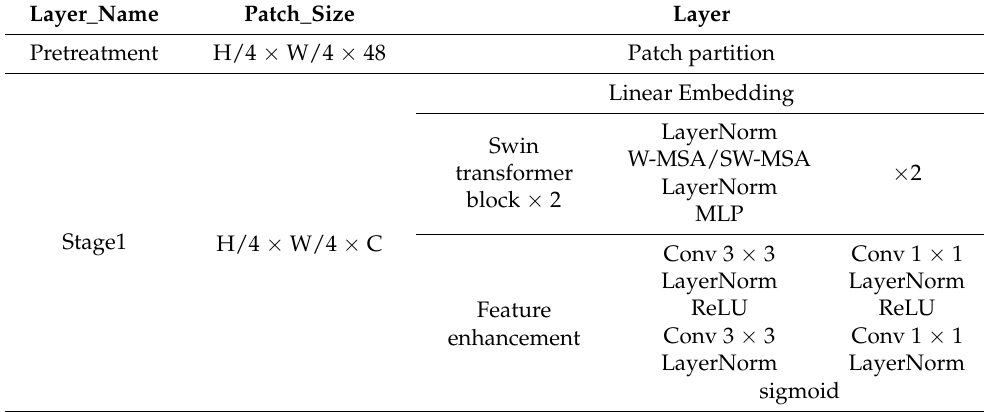
Figure 5. The architecture of ESTDNet. Using the FESwin and AFF modules is shown in detail. Table 1. The FESwin model